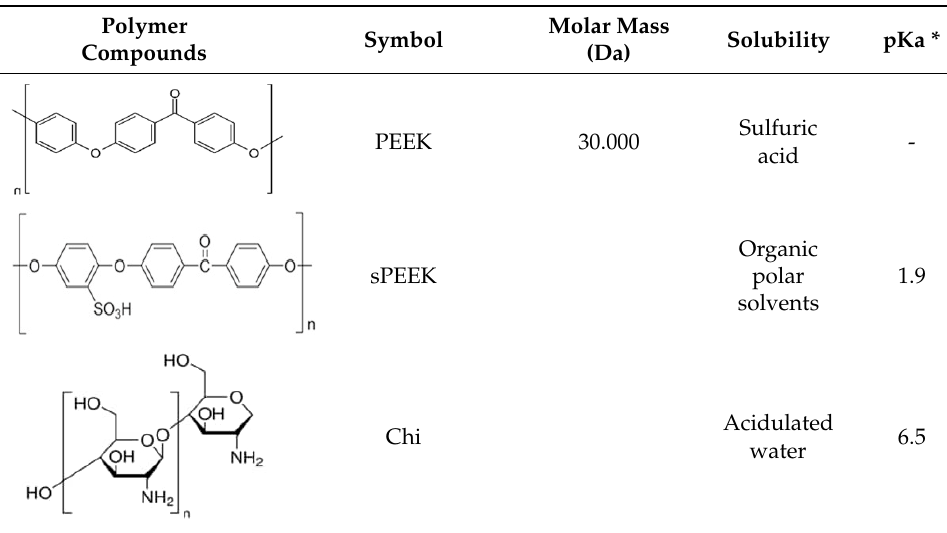
Table 1. The characteristics of the used polymeric and derivative compounds.